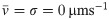
Examples of theoretical f(q, τ) at q = 0.34μm−1 for typical parameters.fm(q, τ) from Eq 7 for oscillatory motion (green): v¯=σ=0μms-1, f0 = 25 Hz, A0 = 3 μm; ballistic motion (red): v¯=150μms-1, σ = 70 μm s−1, f0 = 25 Hz, A0 = 0 μm; oscillatory and ballistic motion (orange): v¯=150μms-1, σ = 70 μm s−1, f0 = 25 Hz, A0 = 3 μm; diffusive motion (grey): fd(q, τ) for Dd = 0.3 μm2, and diffusive motion (black): fnm(q, τ) for Dnm = 0.03 μm2 s−1. Full f(q, τ) (blue): from all four (additive) contributions if swimming spermatozoa contribute 50% of the signal, debris 25% and non-motile spermatozoa 25%.